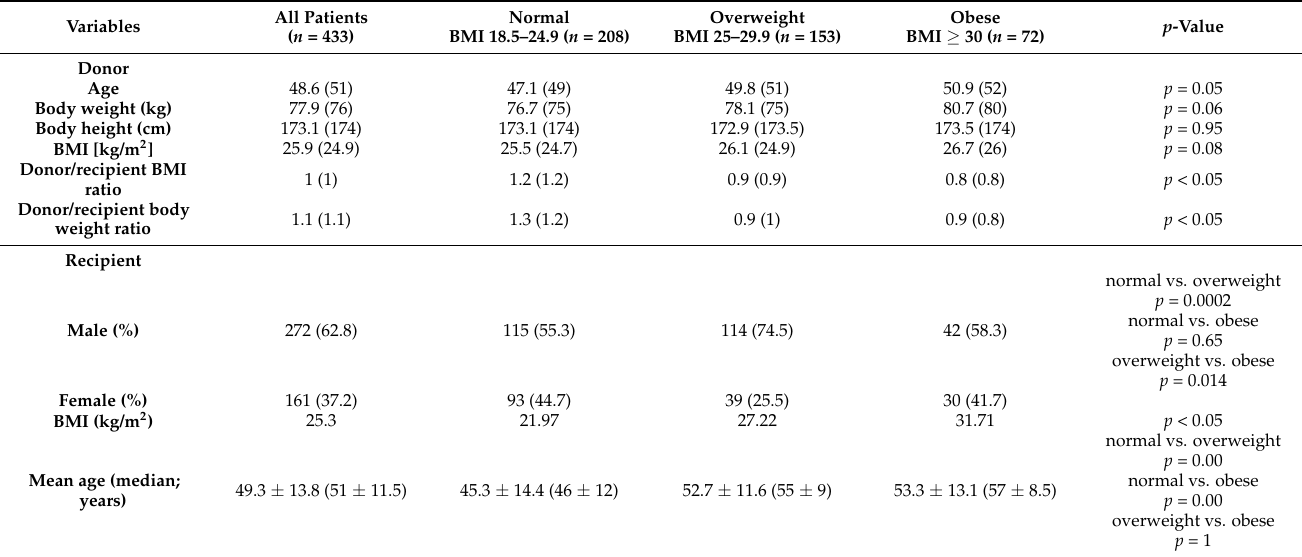
Table 1. Baseline characteristics of all studied groups of patients, the kidney transplantation proce- dure, and the comparison between normal (BMI < 25), overweight (BMI 25–30) and obese (BMI ≥ 30) kidney